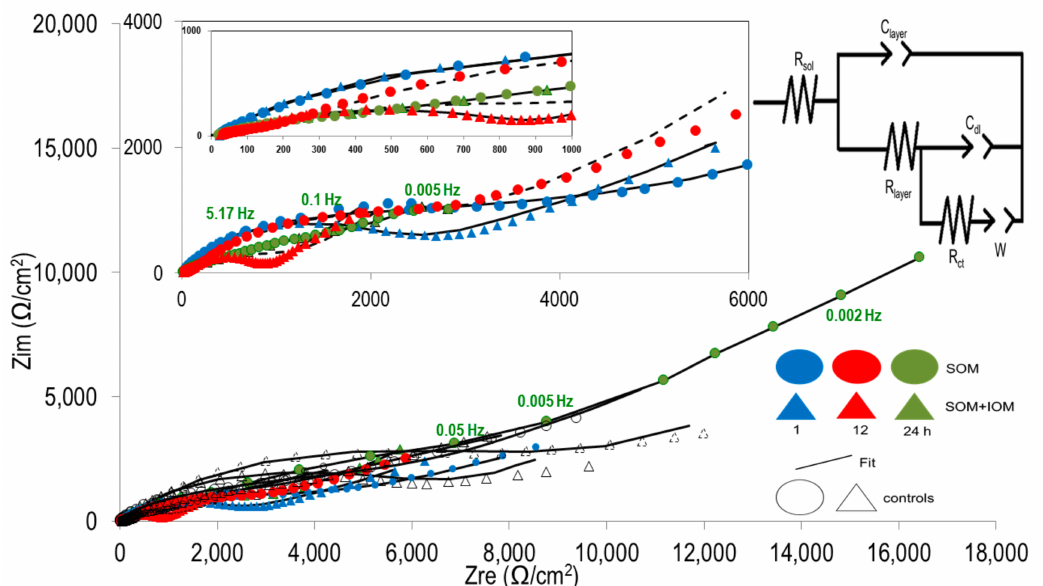
Figure 4. Nyquist diagram for MCE*-S 0 in presence of SOM (triangle) and SOM+IOM (circle) after the assayed times: 1 (blue), 12 (red) and 24 h (green). The equivalent circuit is also presented. R sol : Resistance of the solution (electrolyte); C layer and R layer : Effective capacitance activity and resistance on the MCE*-S 0 /biofilm interface, respectively; C dl and R ct : Charge redistribution and resistance on the interface, respectively; W: Warburg